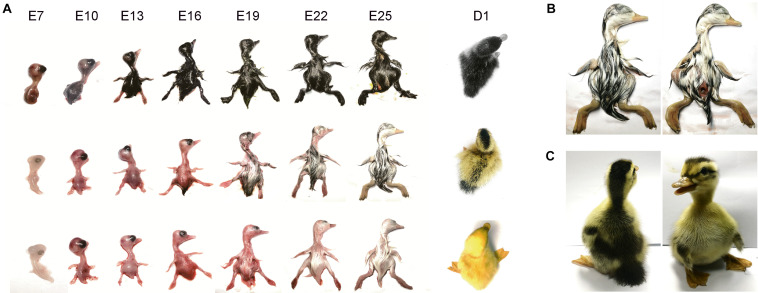
Pigment distribution in embryos. (A) Changes of plumage color phenotype during embryonic development. From left to right represent different stages of embryonic development; from top to bottom represent black, LBM and white duck. (B) Differences of dorsum and ventral side plumage color in LBM embryos. (C) Differences of dorsum and ventral side plumage color in LBM ducks after hatch.